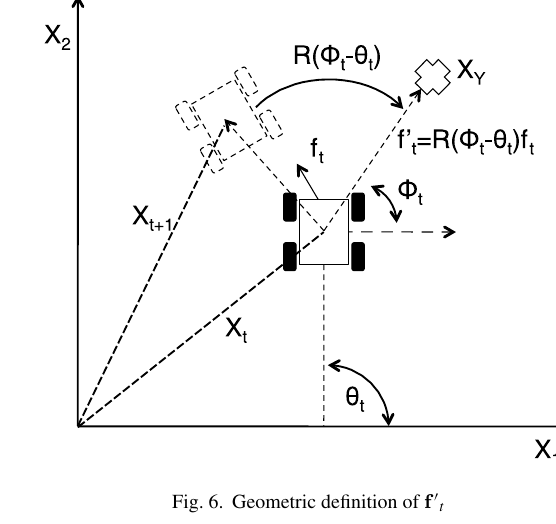
Table 4 Algorithm Robot’s actual orientation